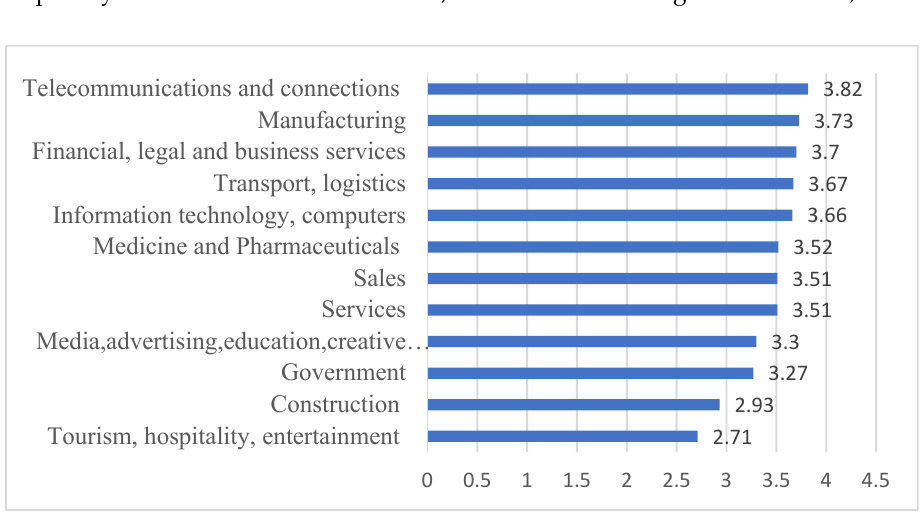
Figure 3. Attitude towards AI among employees according to company size.